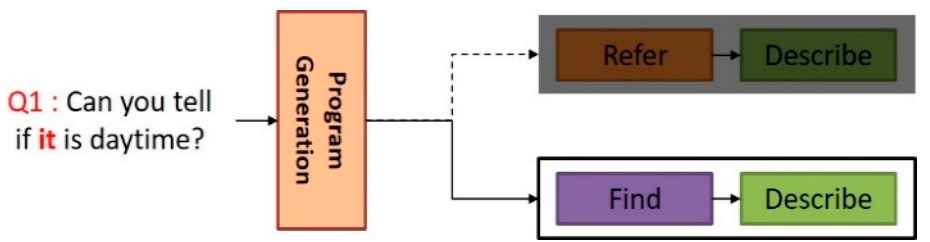
Figure 7. Creating a program for processing impersonal